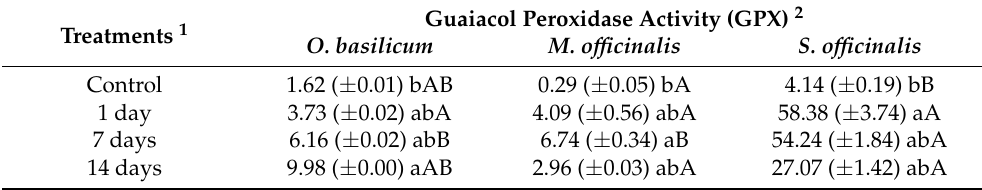
Table 5. Guaiacol peroxidase activity (U mg − 1 FW) within leaves of Ocimum basilicum , Melissa officinalis and Salvia officinalis after Tetranychus urticae infestation. Guaiacol Peroxidase Activity (GPX) 2 Treatments 1